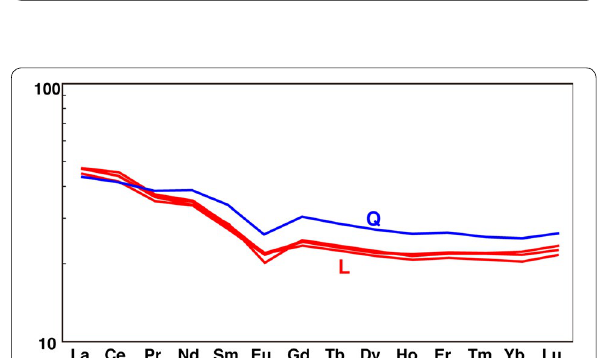
Fig. 13 Chondrite-normalized REE patterns for pumices in the Epi- sodes L (Hachinohe Ignimbrite; SiO 2 66.6–71.8 wt%) and Q (Ofudo = Ignimbrite; SiO 2 62.2–67.8 wt%) of Towada Volcano. Data are from = this study (Additional file 1: Appendix